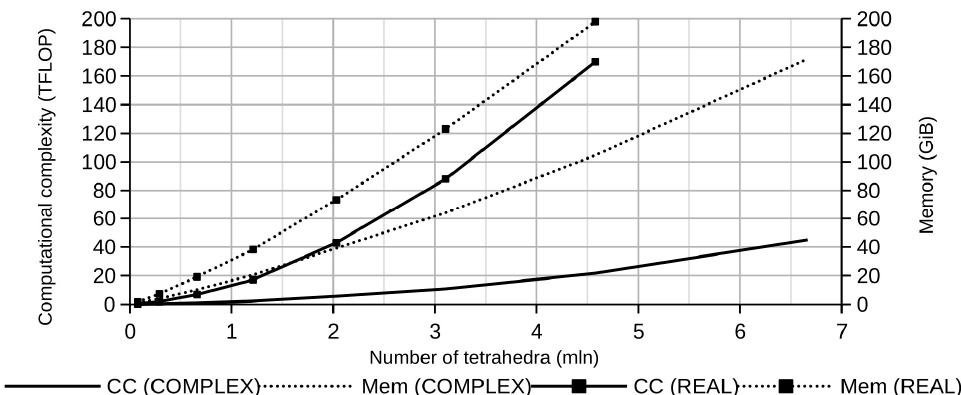
Figure 5. The computational complexity (“CC”) of the numerical problem and the necessary amount of memory (“Mem”) for its solution. The PETSc toolkit was configured to use double-precision real number arithmetic (“REAL”) and double-precision complex number arithmetic (“COMPLEX”).